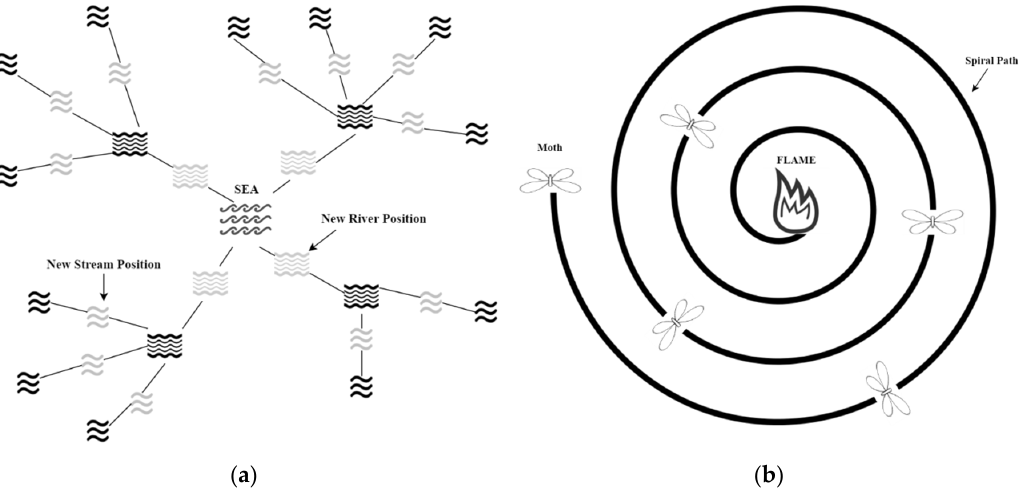
Figure 3. ( a ) Water cycle algorithm (WCA) schematic diagram; ( b ) spiral fly pattern of the moths around a flame.